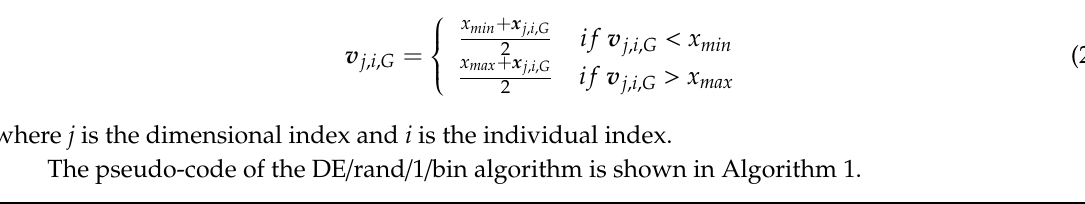
Algorithm 1 DE / rand / 1 /